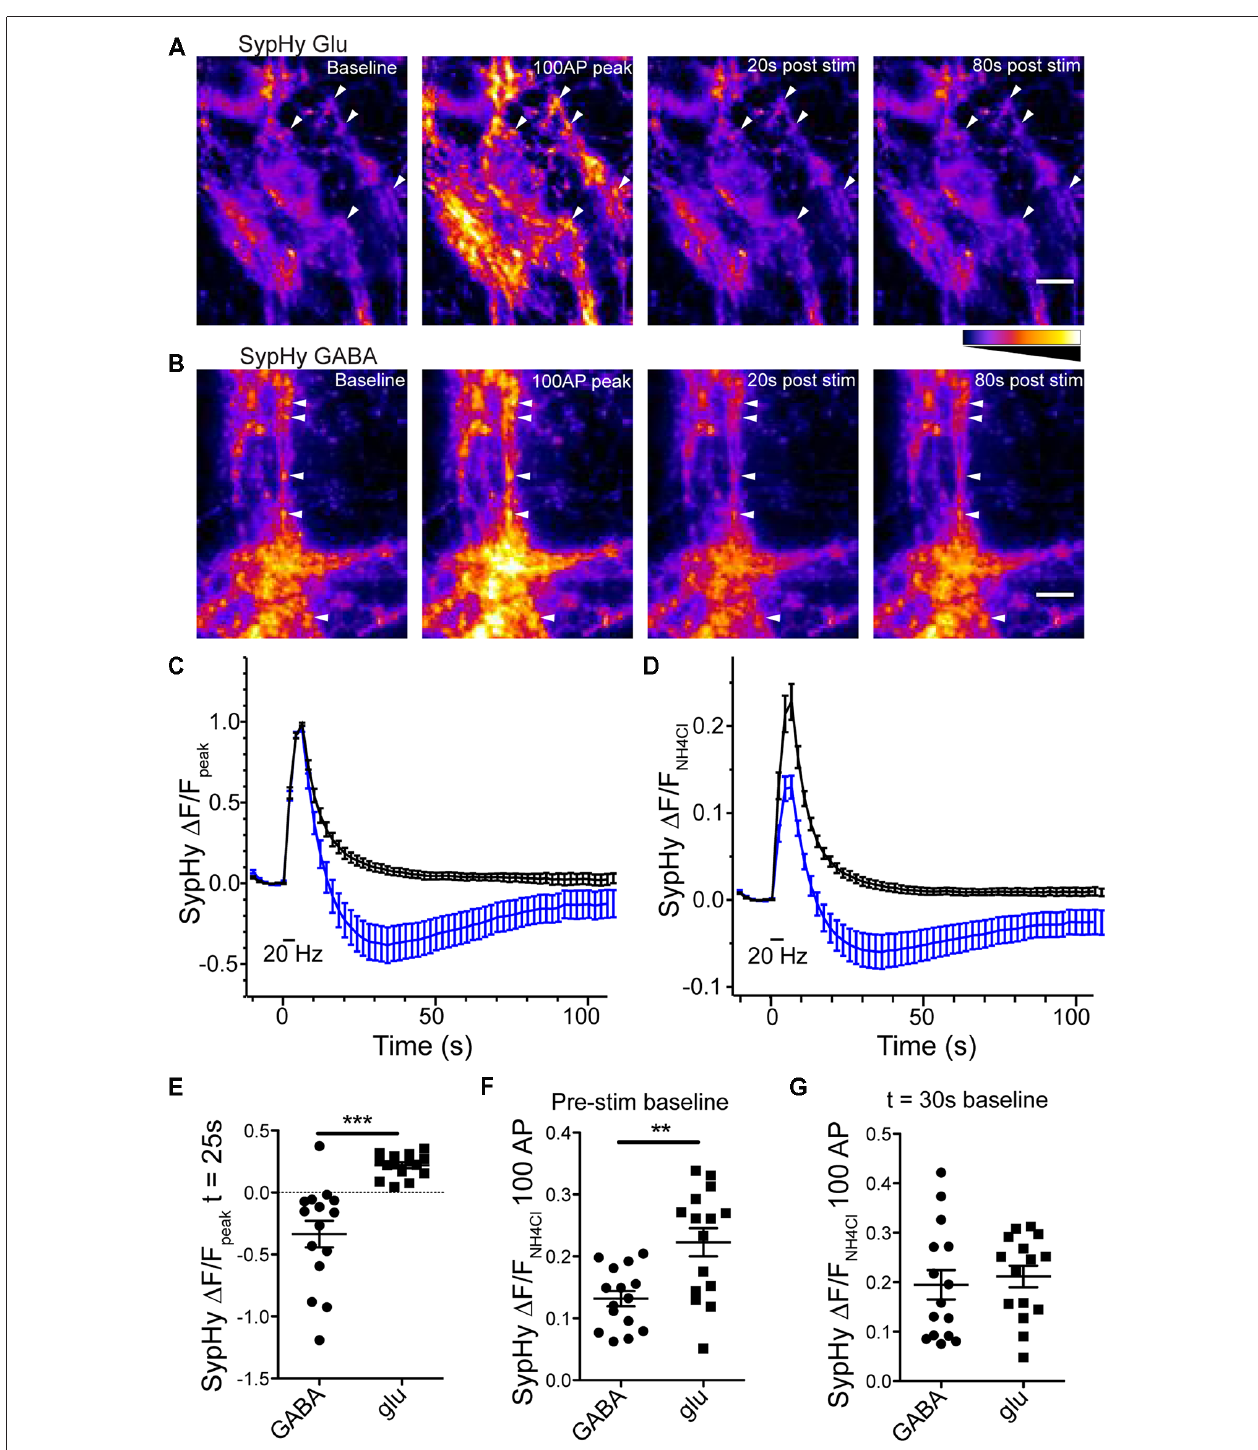
FIGURE 2 | Reacidfication profile of SypHy differs in glutmatergic and GABAergic synapses. SypHy specifically expressed in glutmatergic (A) or GABAergic (B) synapses using flox or SWITCH expression vectors, respectively. Panels display SypHy fluorescence at baseline, immediately following a 100 pulse, 20 Hz stimulus, and 20 or 80 s post-stimulus. All panels set to intensity scale 0–2500 a.u. Scale bar = 10 µ m. Arrows indicate select regions of interest (ROIs). For analysis, the baseline fluorescence for each image was subtracted from the 100 AP image (100 AP ∆ F). ROIs were selected from the 100 AP ∆ F. All ROIs for a given image were measured as fluorescence over time and averaged to give a single fluorescence trace for each image. (C,D) Average change in SypHy fluorescence over time